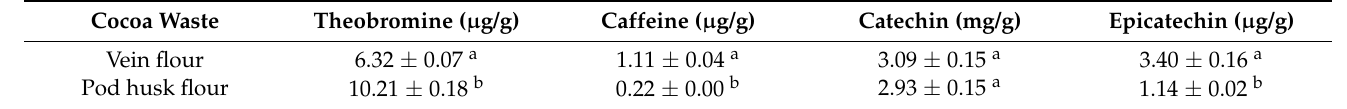
Table 5. Main compound quantitative analyses by HPLC in flour from vein and pod husk of